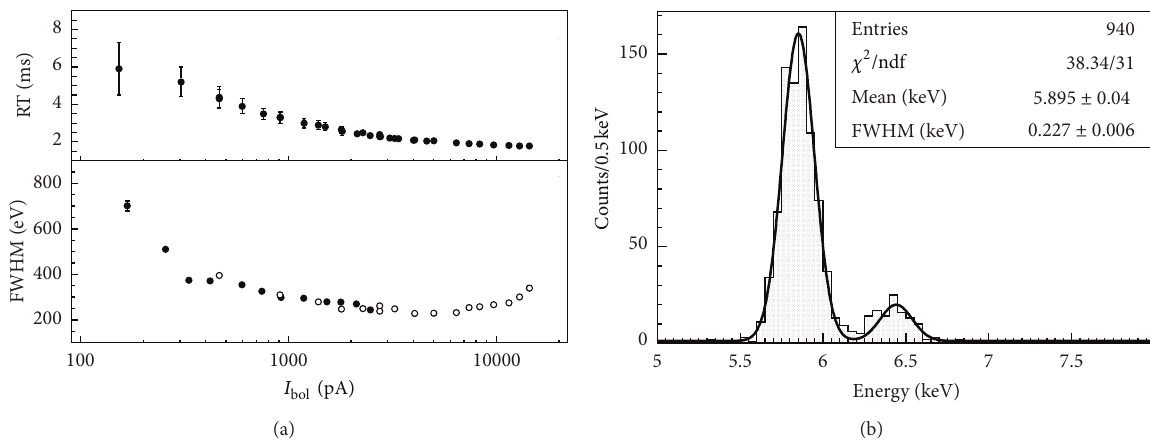
Figure 3: (a) LD performances (rise time and FWHM energy resolution) as a function of the polarization current, using load resistors of 11G Ω (black dots) and 2 G Ω (open circles). (b) calibration spectrum of the detector, using a 55 Fe X-ray